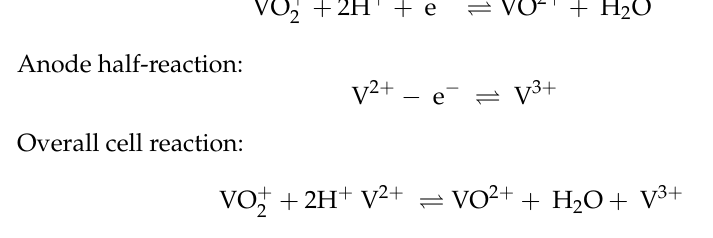
Figure 19. All-vanadium redox flow battery.